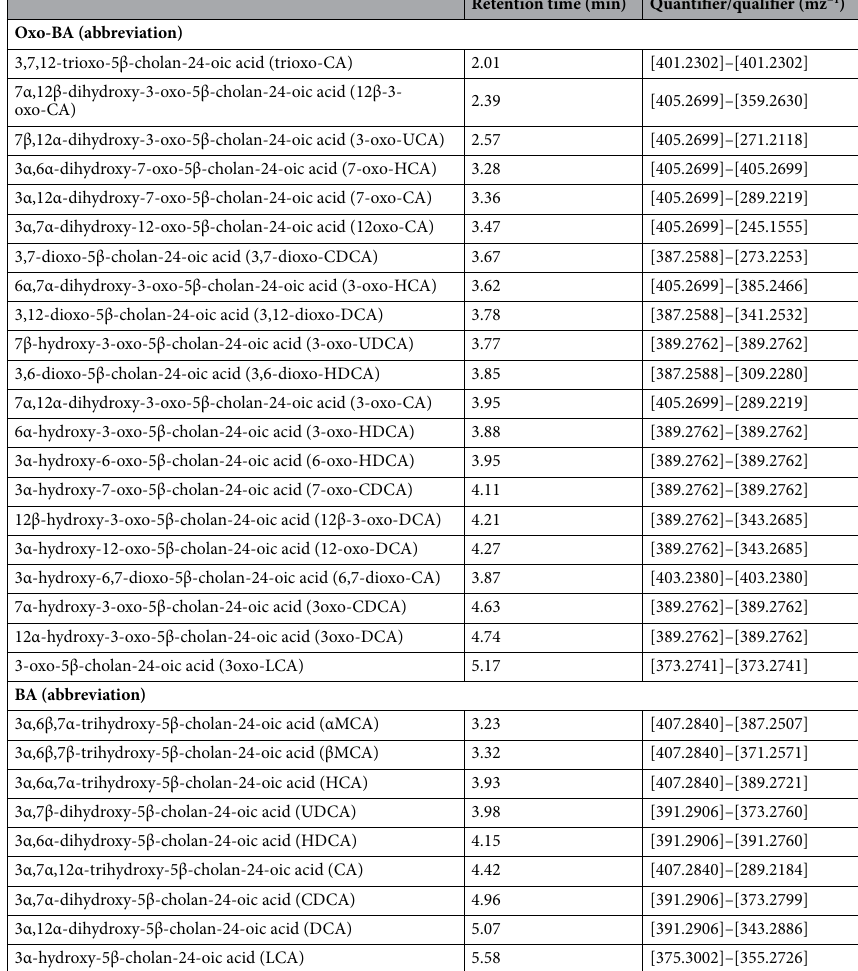
Table 1. List of the analysed BAs and their metabolites with abbreviations, retention times, and quantifier/ qualifier